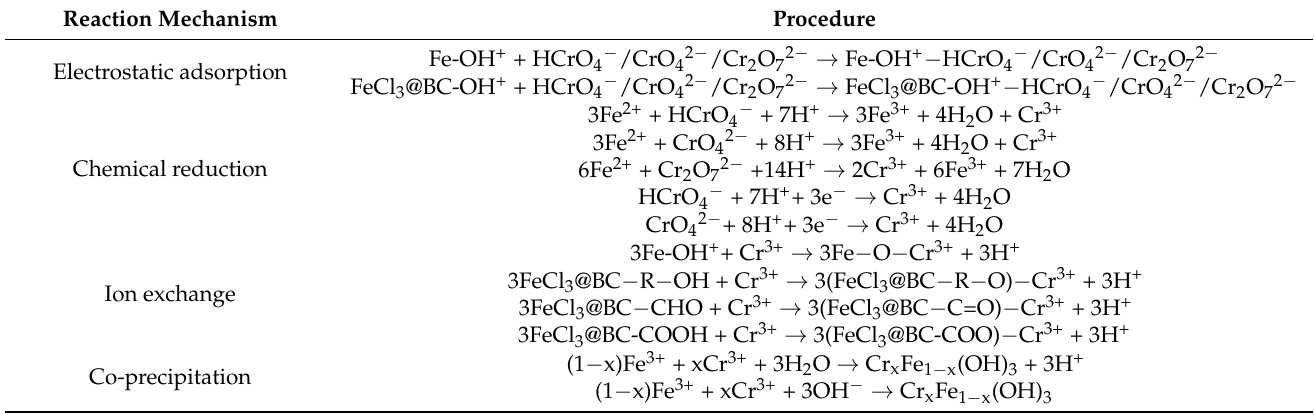
Figure 7. The mechanisms of hexavalent chromium Cr(VI) elimination by FeCl 3 @BC. Table 5. Adsorption mechanism of Cr(VI) via FeCl 3